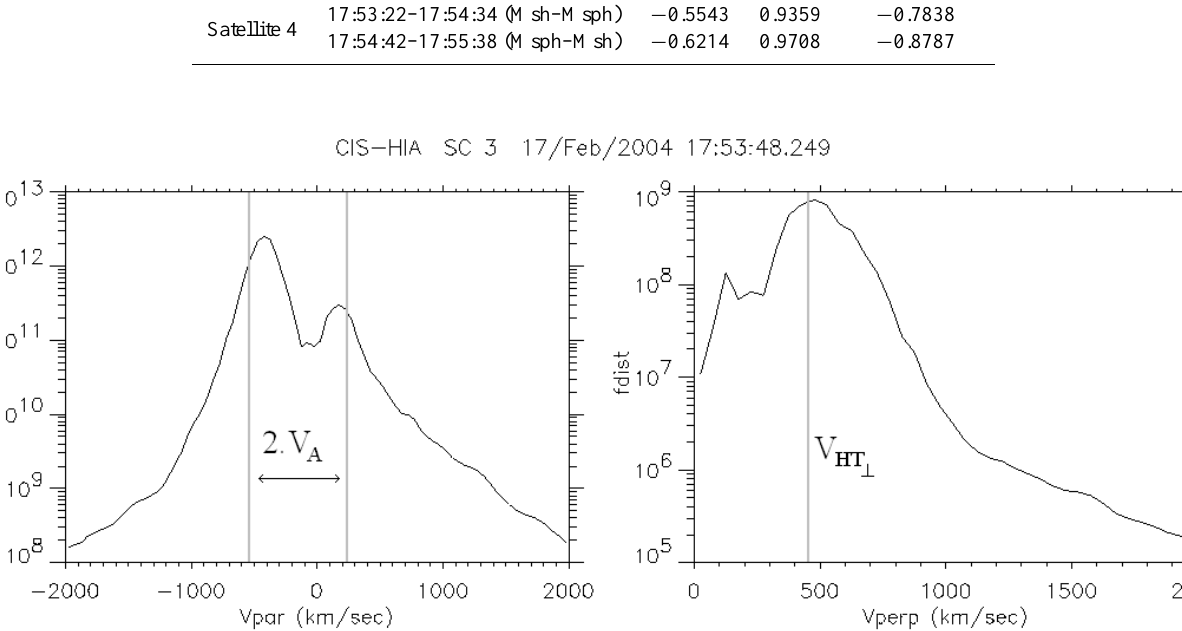
Fig. 7. 17 February 2004, 17:53:48.289UT. Ion distribution function with respect to their velocity parallel to the magnetic field (left panel) and to their velocity perpendicular to the magnetic field (right panel) from SC3 HIA instrument. In the left panel, the two vertical lines represent respectively the component parallel to the magnetic field of V HT – V A and V HT + V A . In the right panel the vertical line represents the component of the dHT velocity perpendicular to the magnetic